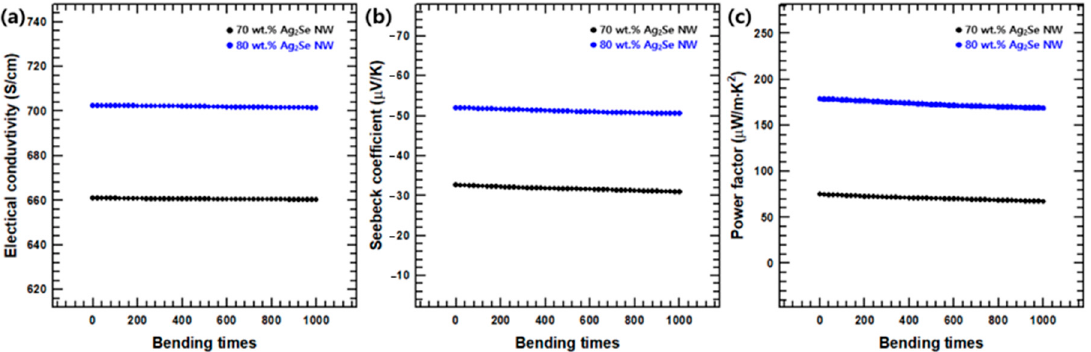
Figure 6. ( a ) Electrical conductivity, ( b ) Seebeck coe ffi cient, and ( c ) power factor of Ag 2 Se NW / PEDOT:PSS composite films with 70 and 80 wt.% of Ag 2 Se NW as a function of bending